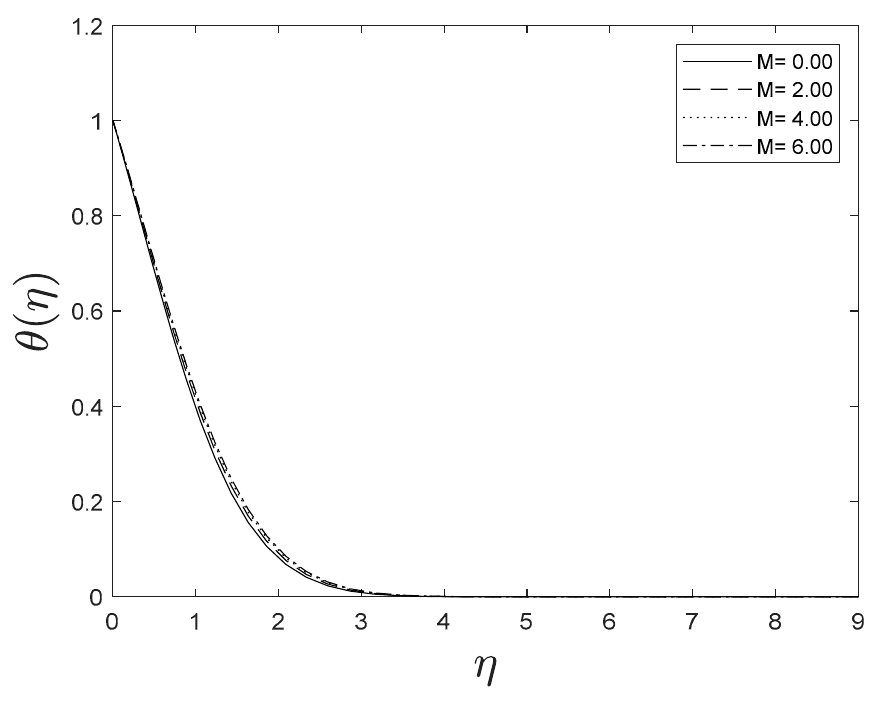
Figure 3. Effect of different values of M on θ ( η )